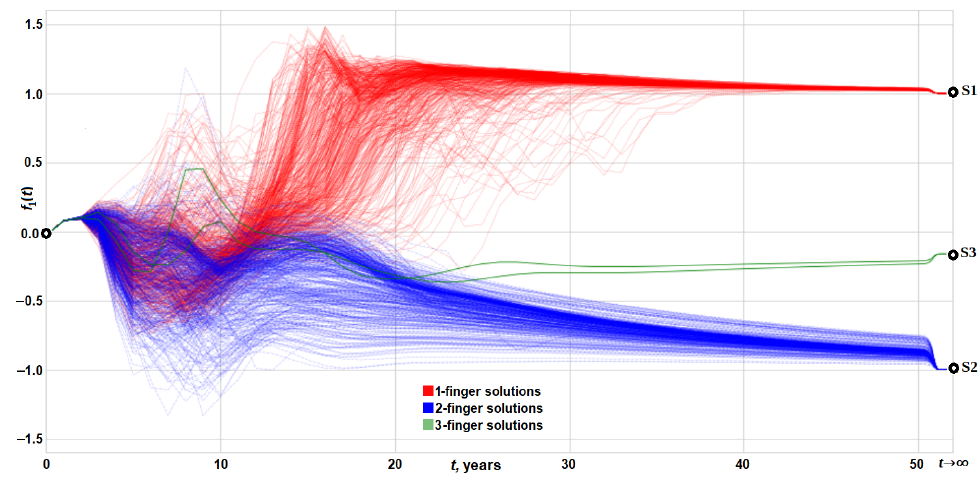
Figure 3. The behavior of the feature (12) in time for the ensemble of N = 10,000